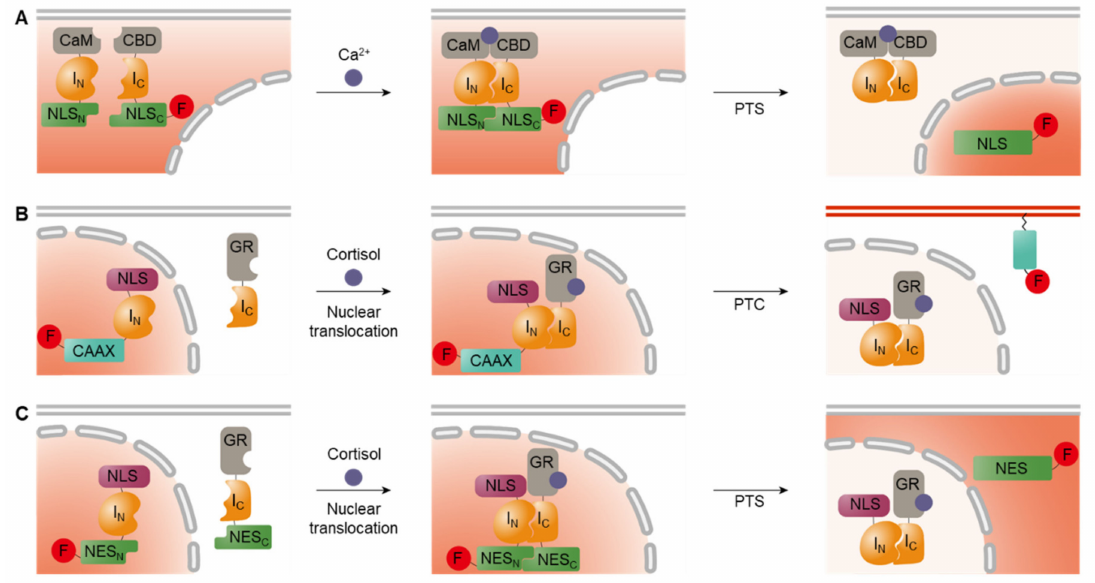
Figure 5. Cell-based sensor design via signal peptide reconstitution. ( A ) Nuclear location signal (NLS) peptide reconstitution triggered by CPS. ( B ) Activation of CAAX tag induced by CPC. ( C ) Nuclear export signal (NES) peptide reconstitution triggered by